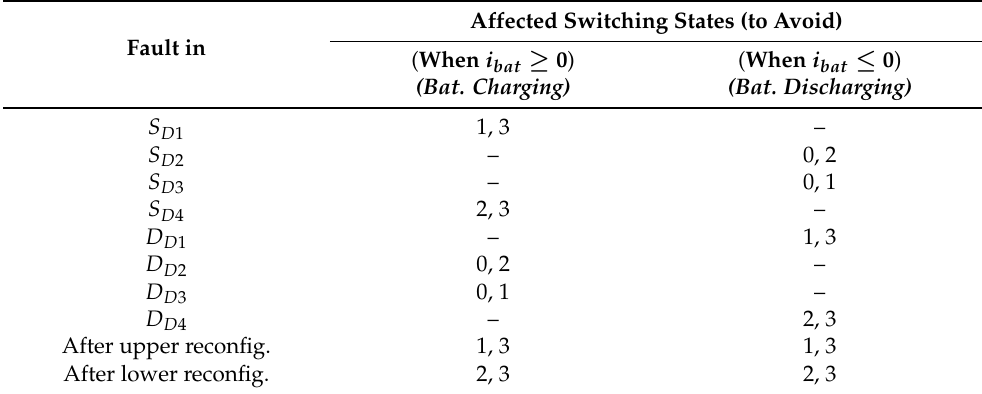
Table 3. Switching States Affected by each Fault in the 3LDC Converter (to Avoid by the Controller). Affected Switching States (to Fault in